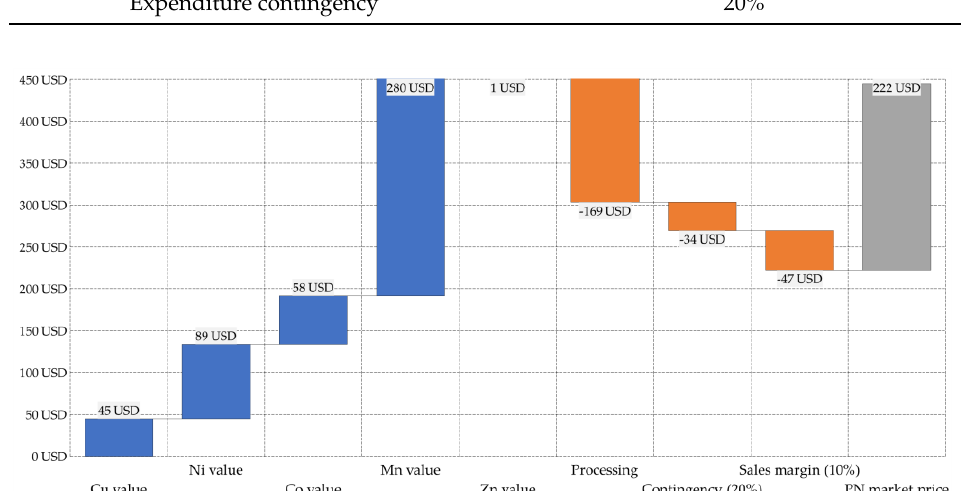
Figure 5. Estimation of the market unit price of PN (USD/ton) based on HPAL technology (revenue and processing costs).